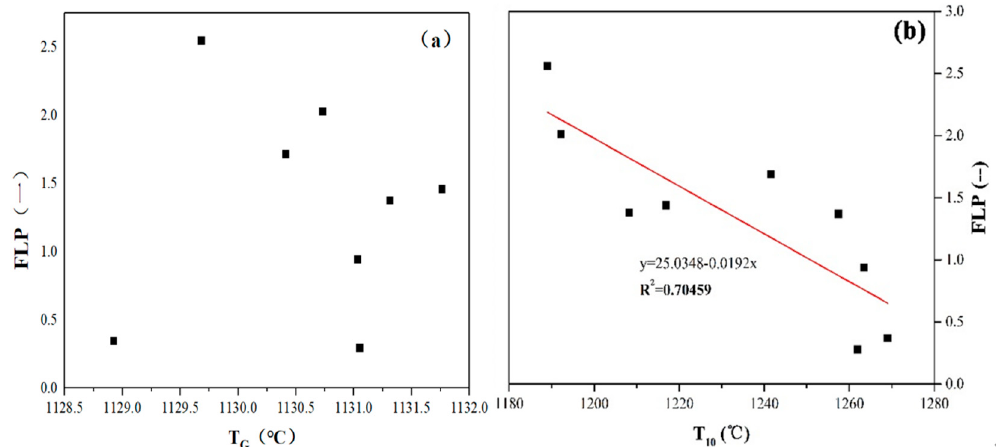
Figure 6. Relationship between FLP and melt formation temperature. ( a ) The theoretical generation temperature of liquid phase ( b ) The generation temperature of effective liquid phase.